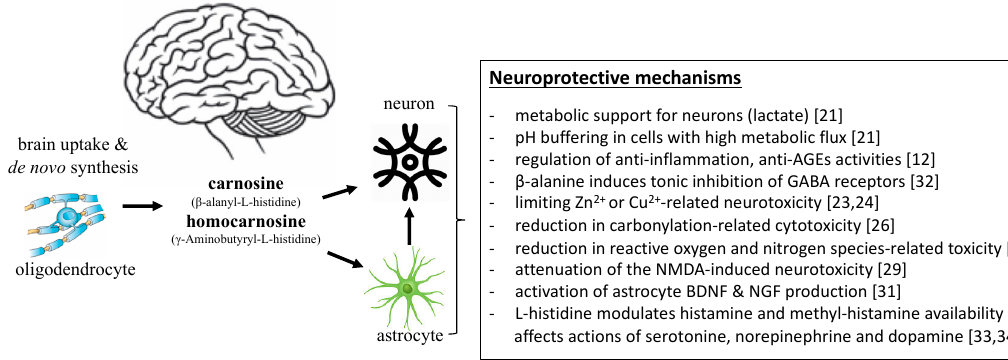
Figure 1. Proposed mechanisms mediating the neuroprotective e ff ects of carnosine in the brain. Carnosine exerts its anti-oxidative actions indirectly through modulation of the endogenous anti-oxidant system as well as directly by decreasing the intracellular levels of reactive species, such as hydroxyl radicals, nitric oxide [25], and cytotoxic carbonyl species [26] (Figure 1). This was confirmed in a study in which administration of carnosine to rat cerebellar cells halved ROS concentrations in neurons [27]. Moreover, carnosine has anti-oxidative capacity against agents increasing ROS [28]. Another neuroprotective action of carnosine includes its attenuation of neurotoxicity induced by NMDA [29], beta amyloid, and inducible nitric oxide synthase [30] as well as increased trophic factors expression [31] (Figure 1). The e ff ects of carnosine were reversed by inhibiting histidine decarboxylase (HDC) as well as histamine H 1 and H 3 antagonists, which suggests that carnosine’s neuroprotective mechanisms include not only the carnosine-histidine-histamine pathway, but also H 1 and H 3 receptors